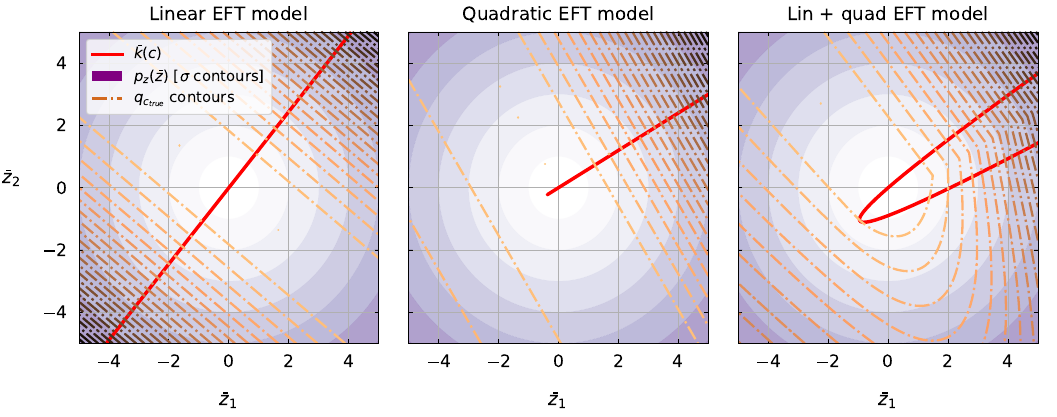
behave dif- c true